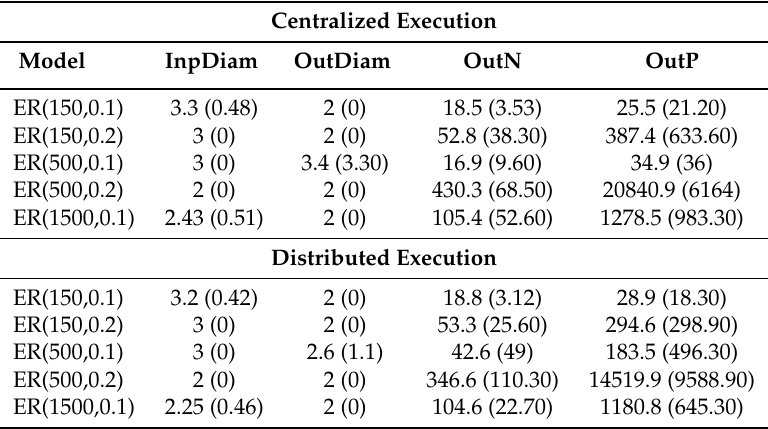
Table 2. Models (Erdos–Renyi), input diameter (InpDiam), output diameter (OutDiam), output nodes (OutN), output feasible pairs (OutP). The standard deviation is shown in brackets.